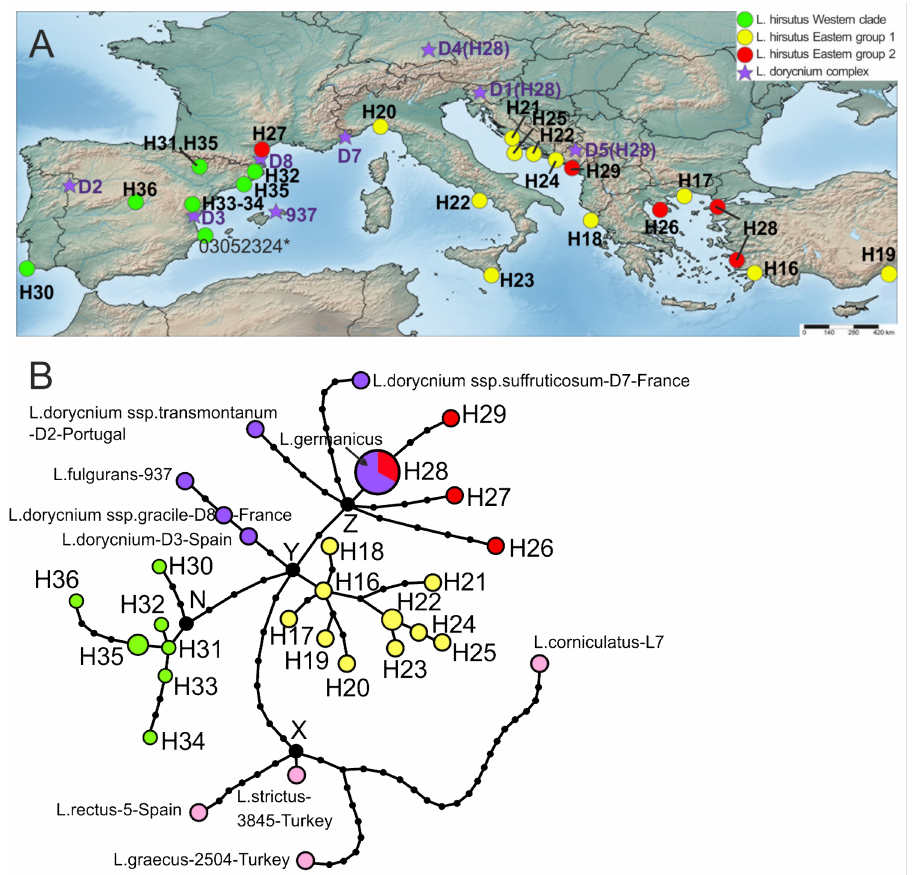
Figure 6. Geographical distribution of haplotypes identified in L. hirsutus ( A ) and haplotype network ( B ) reconstructed based on the combined plastid DNA dataset. The size of each circle is proportional to the frequency of the haplotype in the dataset. L. dorycnium complex, L. strictus , L. rectus , L. graecus , and L. corniculatus represent outgroups. The haplotype of L. hirsutus sample 03052324* was excluded from the network because of incomplete sequence rps 16